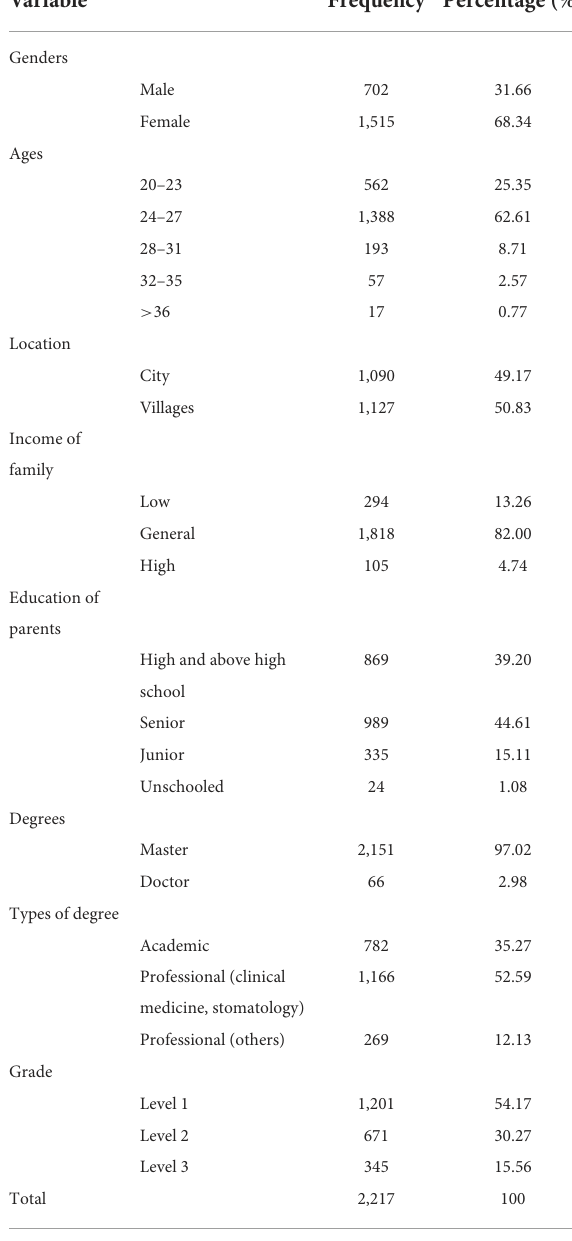
TABLE 1 Descriptive statistics of the participants in the present